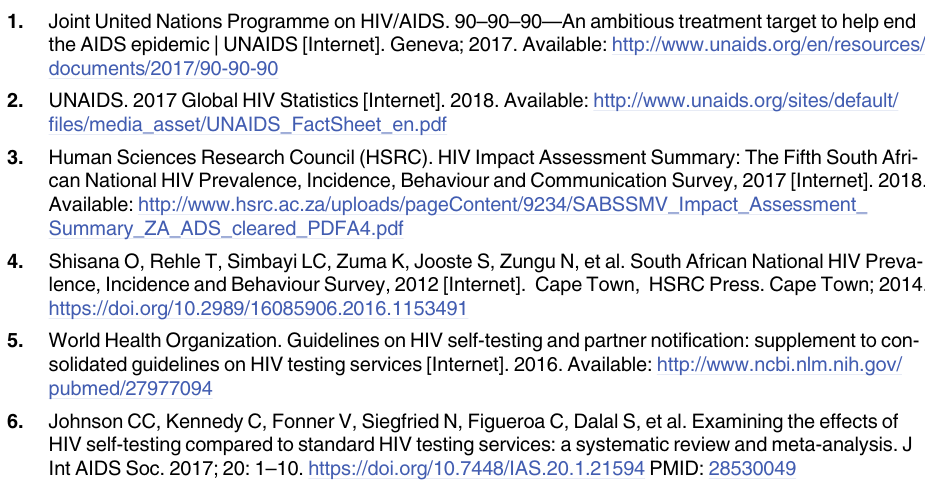
S4 File. Data for Fig 1. Data in